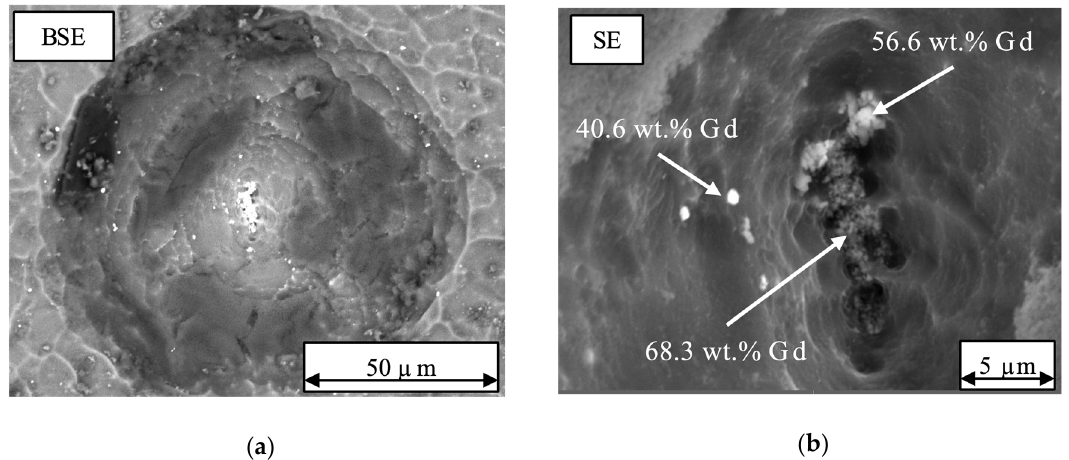
Figure 5. SEM picture of one etching pit on the surface of the Mg-2Gd alloy after etching for 150 s in a 5 mL solution of 250 g/L HAc: ( a ) backscattered electron (BSE)-mode, formation of an etching pit inside the matrix with particles at the center; ( b ) secondary electron (SE) mode: higher magnification of accumulated Gd rich particles (white spots) at the center of an etching pit.